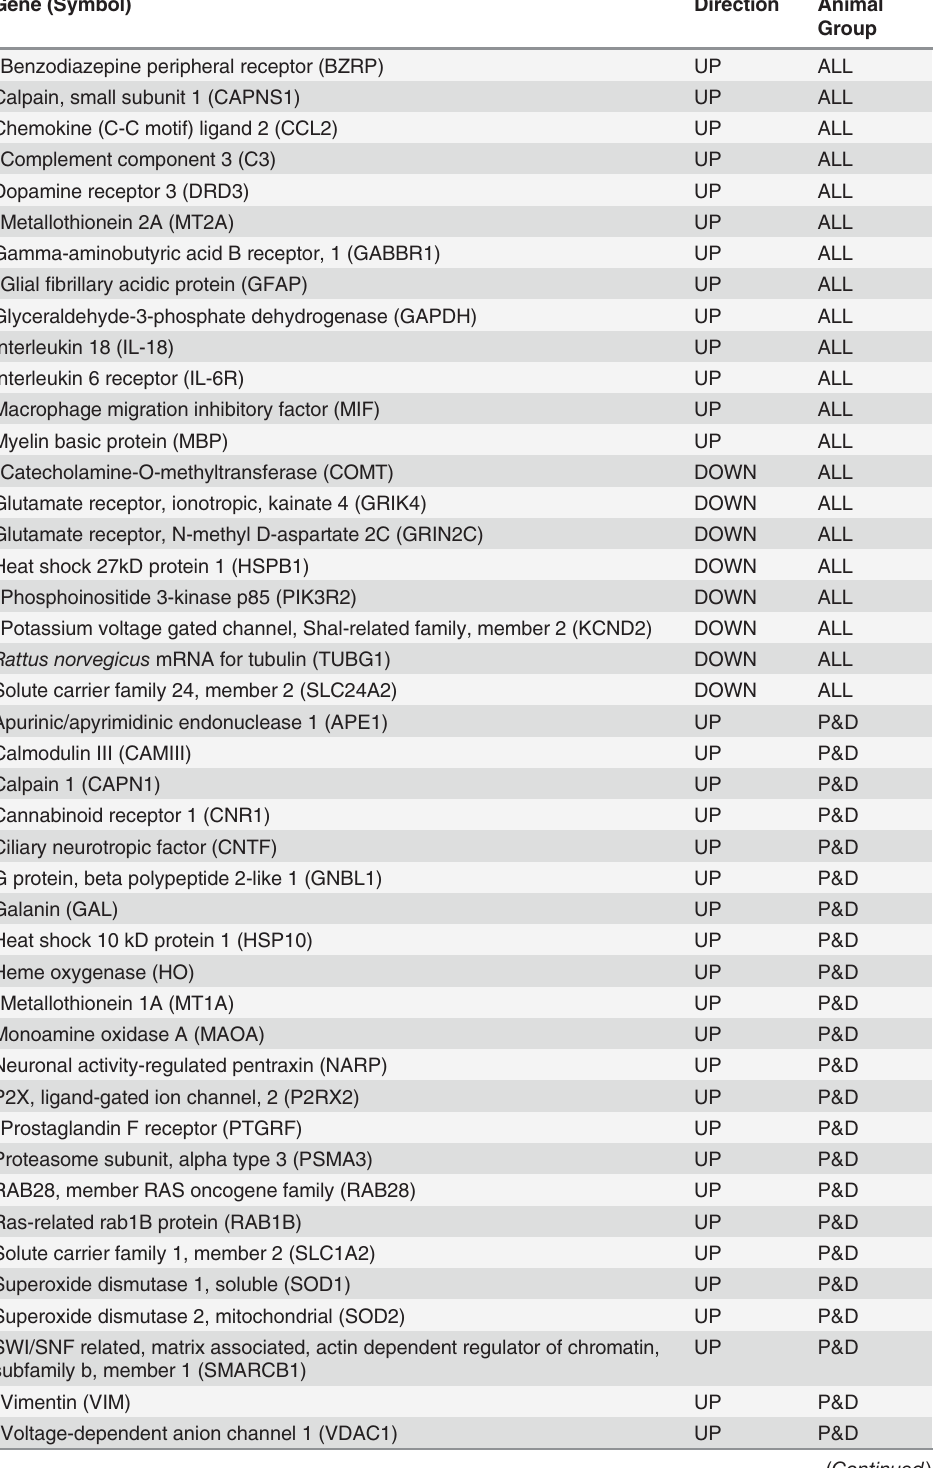
Table 3. A summary of all of the genes up- or down-regulated in the lumbar spinal cord of rats 6 days after CCI as determined by MAS v5.0. Gene